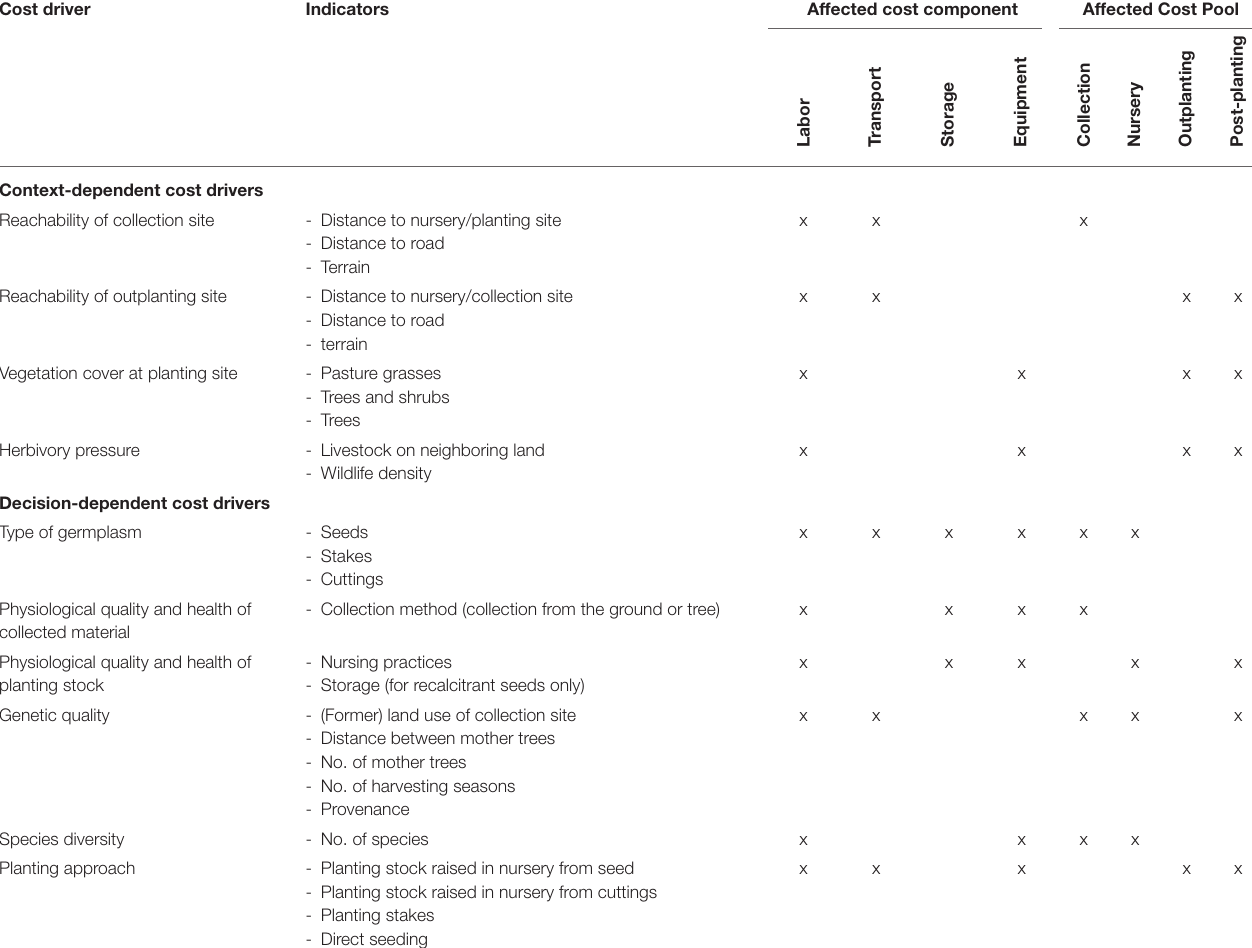
TABLE 1 | Cost drivers with associated indicators and affected cost components and cost